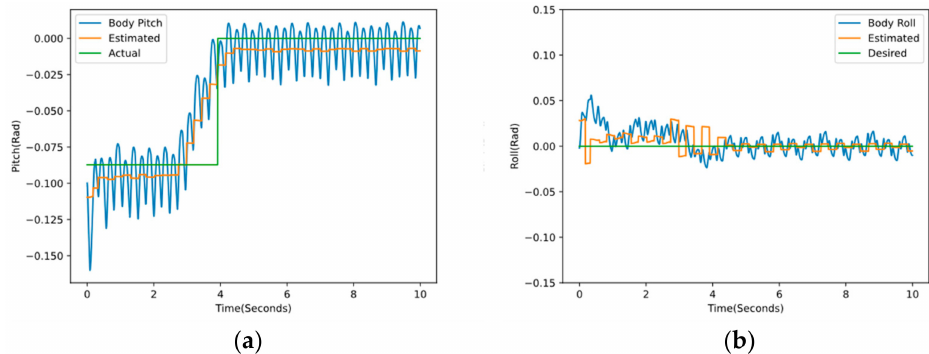
Figure 15. Changes in the attitude angle of the robot on the 5 ◦ slope. ( a ) Changes in the pitch angle of the robot on the 5 ◦ slope. ( b ) Changes in the roll angle of the robot on the 5 ◦ slope.